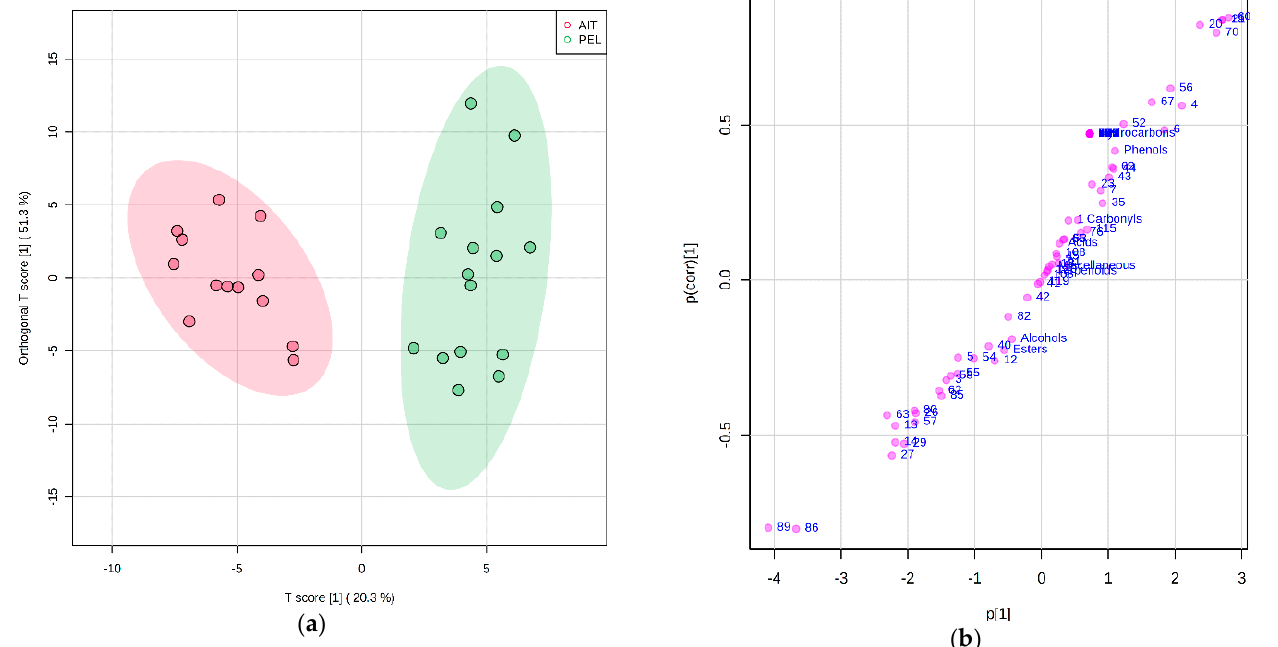
Figure 5. OPLS-DA of the volatile compounds identified in cv. Kalamata natural black olives grown in Aitoloakarnania (AIT—red dots) and southern Peloponnese (PEL—green dots): ( a ) scores plot, and ( b ) loadings S-plot. The shaded areas represent the 95% confidence ellipses. The codes of variables are given in Table 2.